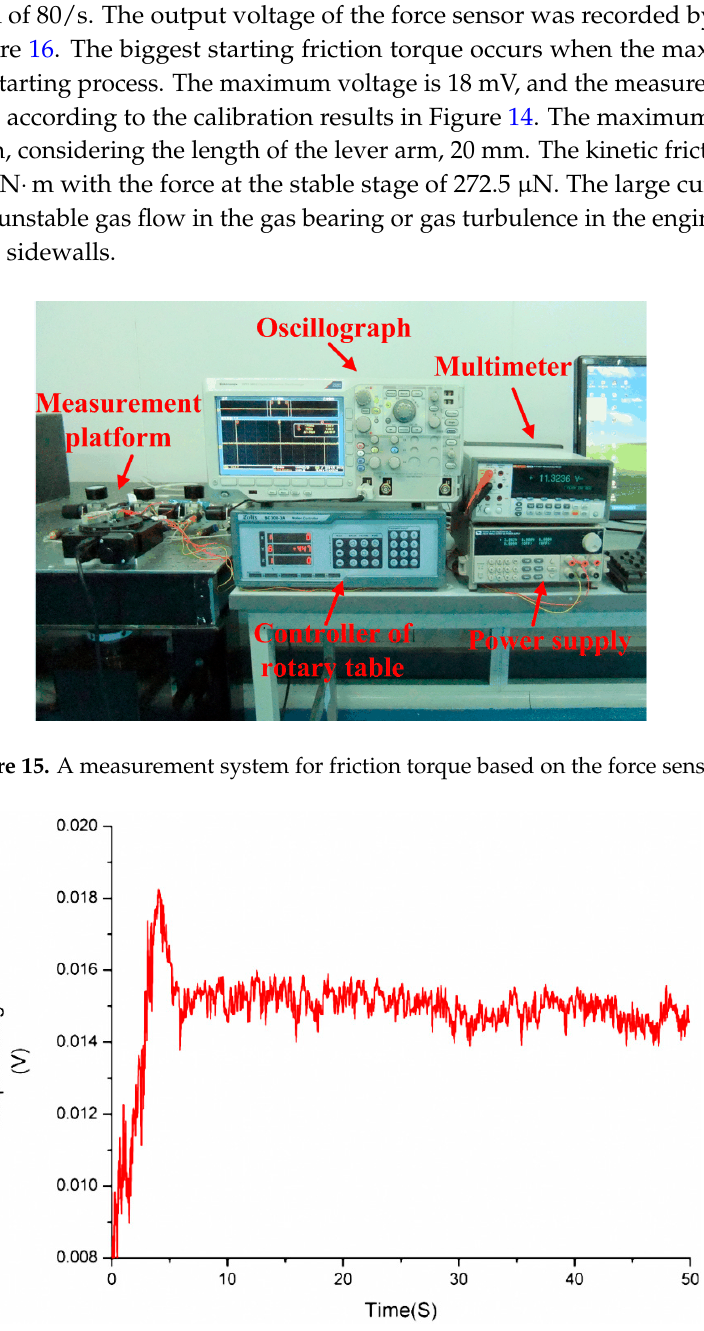
Figure 16. The output voltage of the micro-force sensor under start-up and ready stage.